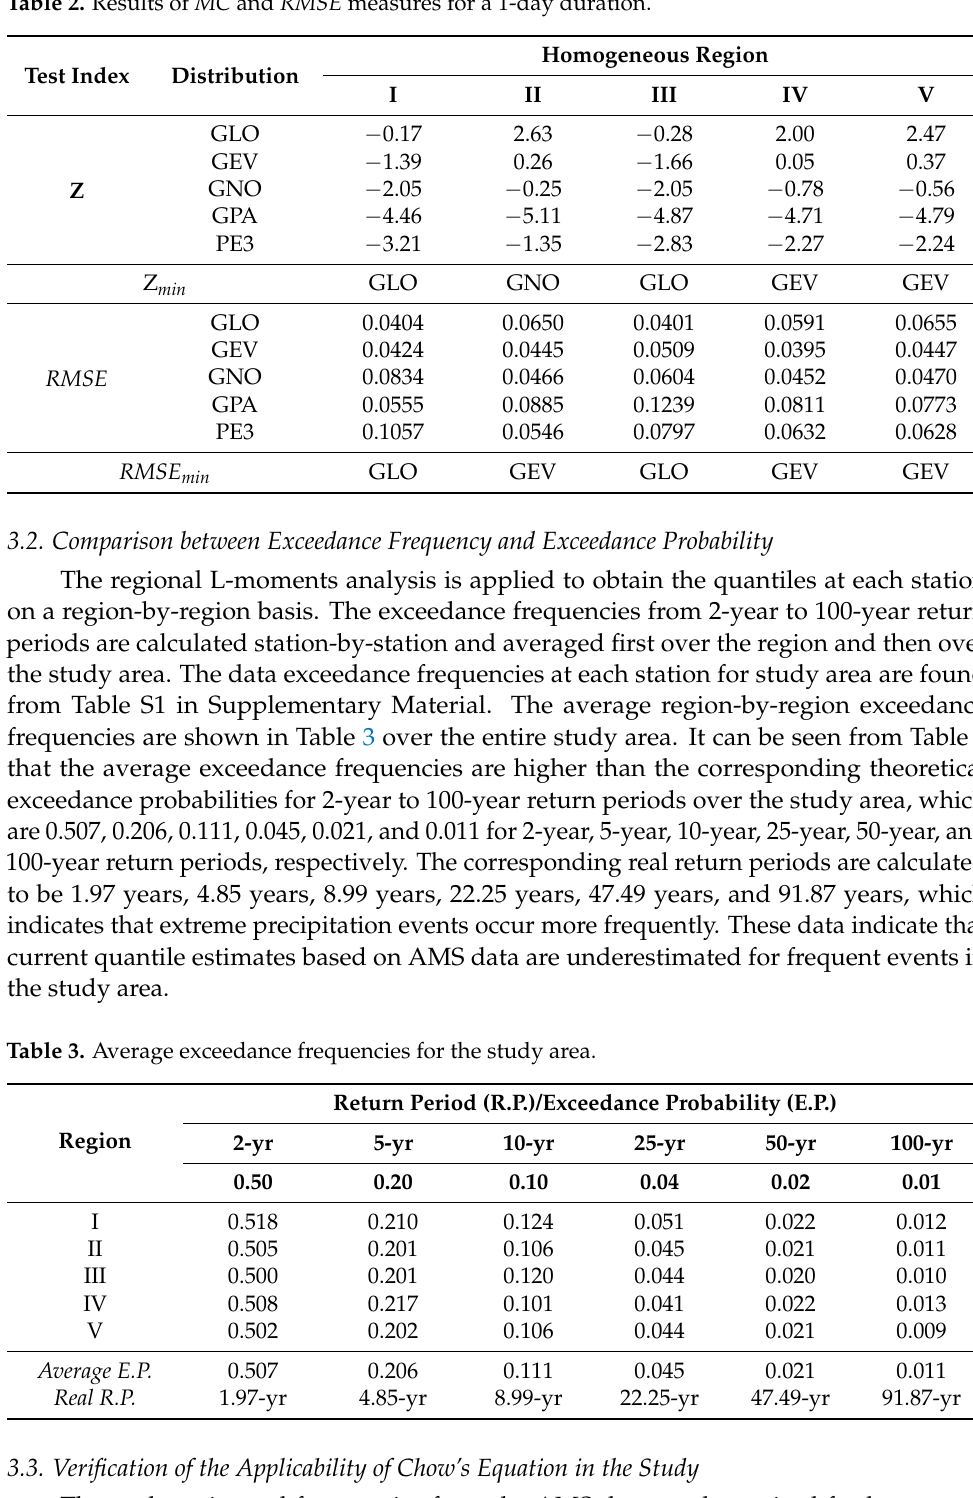
Table 2. Results of MC and RMSE measures for a 1-day duration.